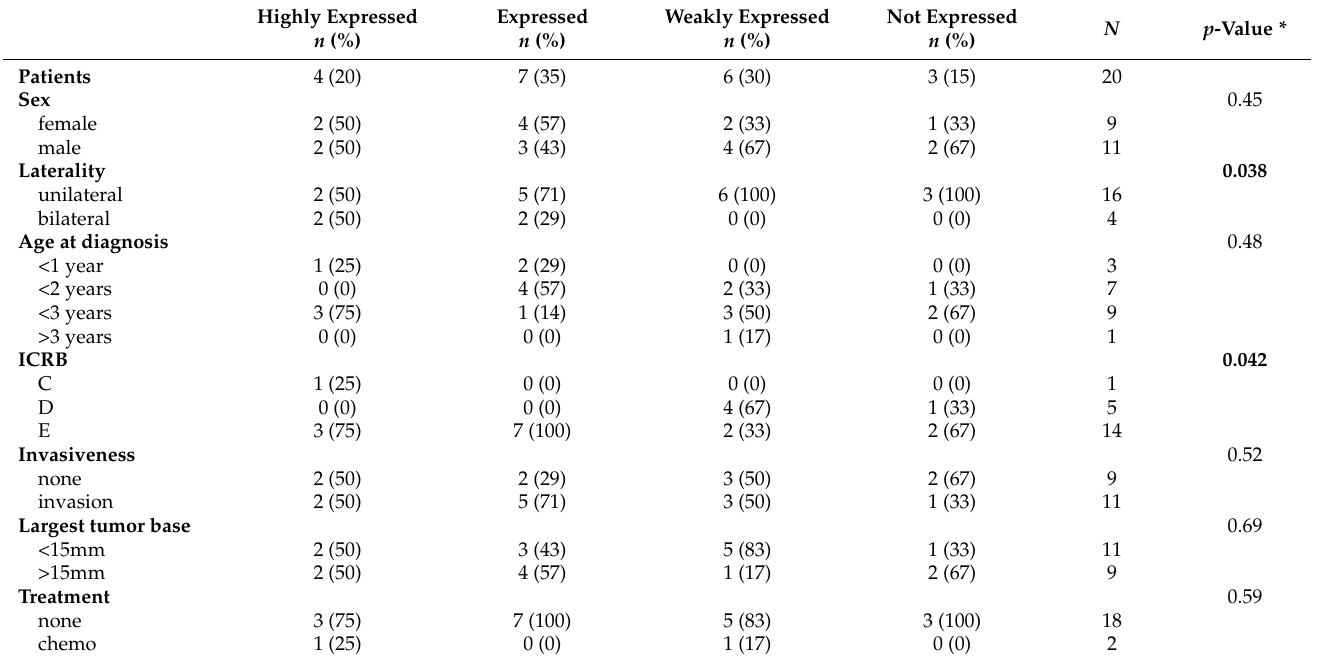
Table 1. Clinical and pathological characteristics of RB patients’ tumors stratified by ADAM17 expression in immunohistochemically